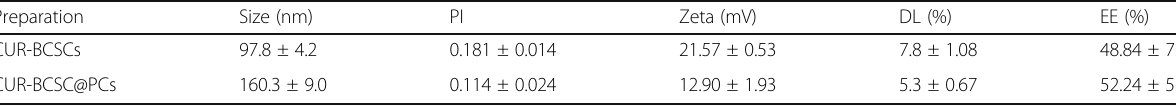
Table 1 The physiochemical properties of CUR-BCSCs and CUR-BCSC@PCs ( n = 3)